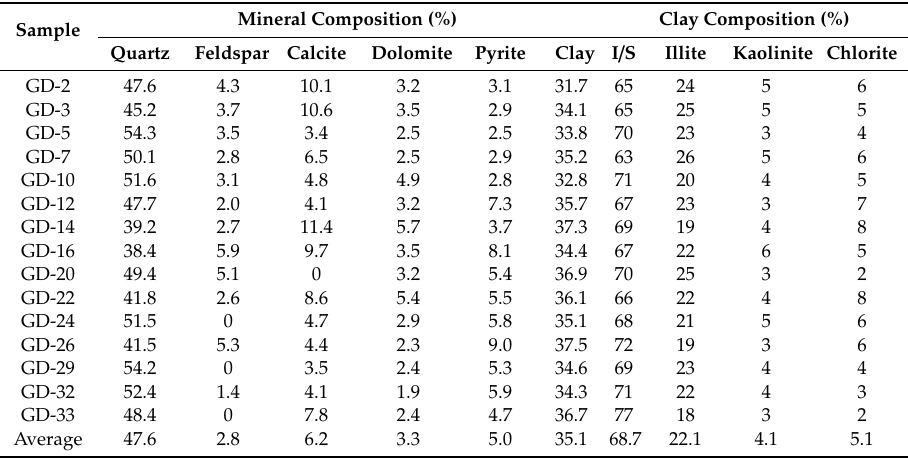
Table 3. Mineral composition and clay composition of the Dalong Formation shales.